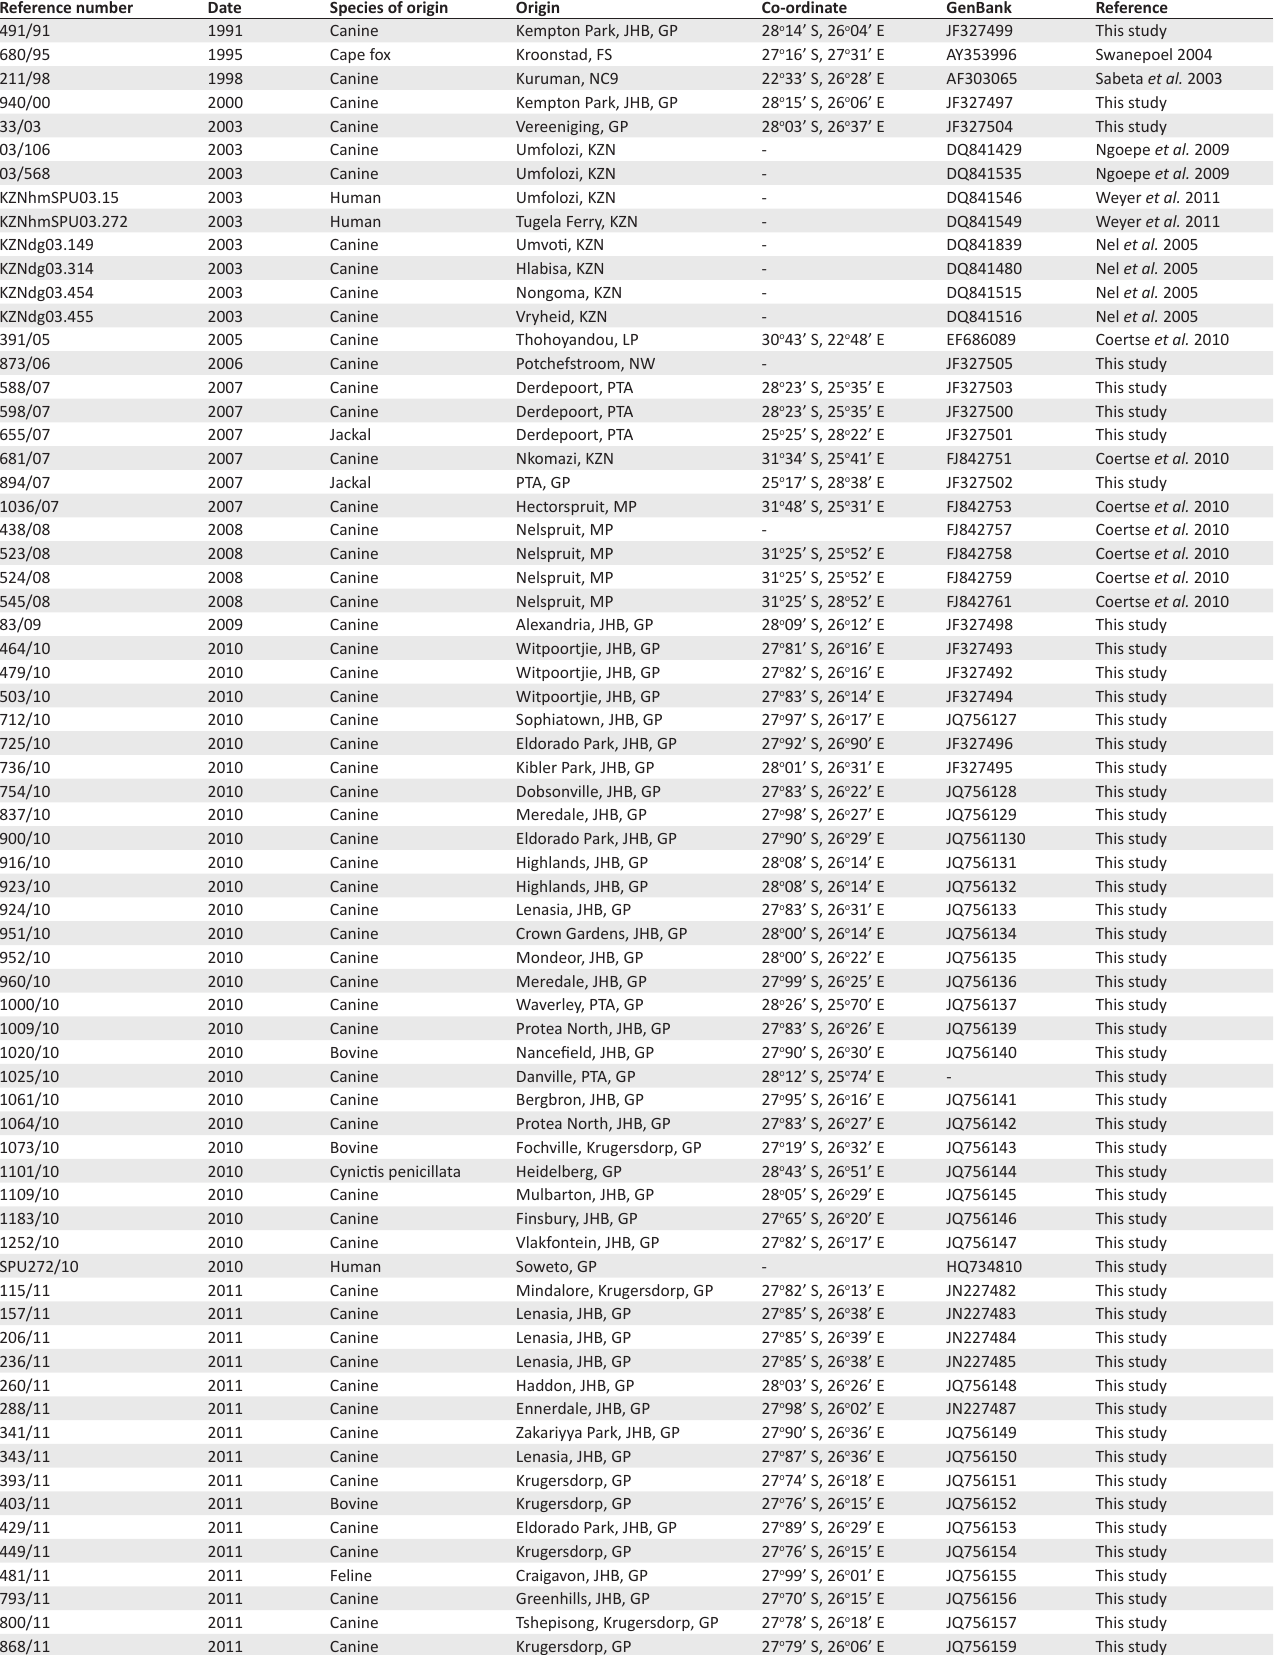
TABLE 1: A panel of 54 original brain specimens from the outbreak period in Gauteng Province. Reference